Question: Give a one-sentence summary of this figure.
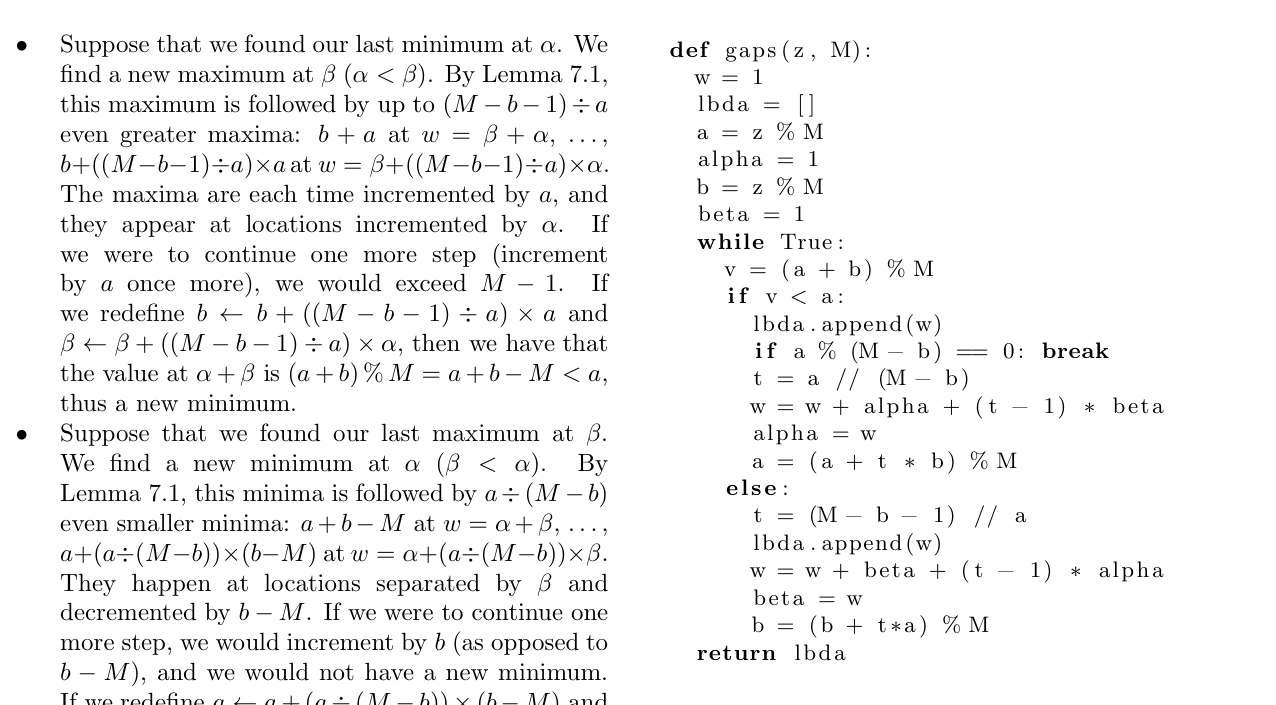
Answer: Python code to compute all of the gaps between the extrema of (w × z) % M for w = 1, 2, . . ., M gcd(z,M) −1. M and z should be positive integers, and z should not be a multiple of M.